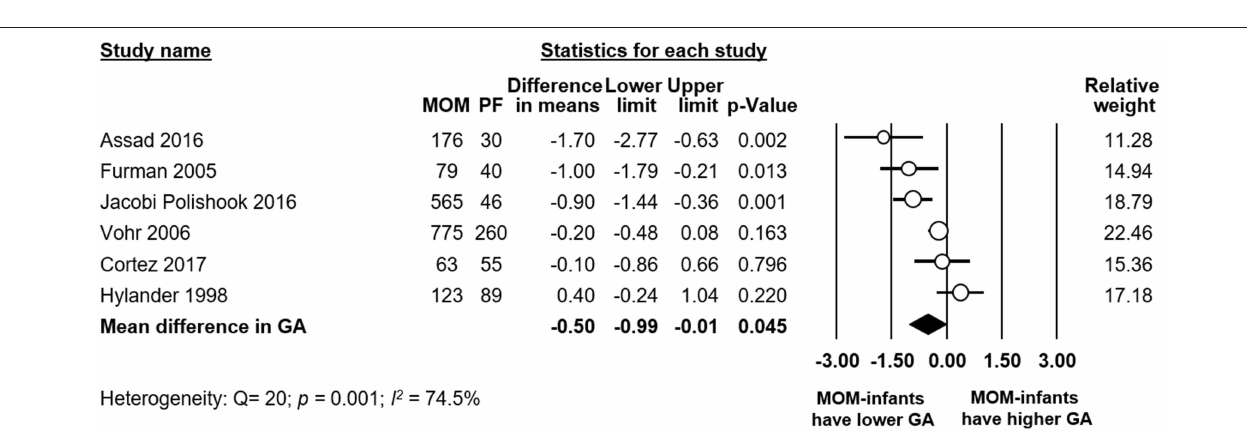
FIGURE 7 | Meta-analysis of Any MOM vs. Exclusive PF, mean difference (MD) in gestational age (GA) between groups. MOM, mother’s own milk; PF, preterm